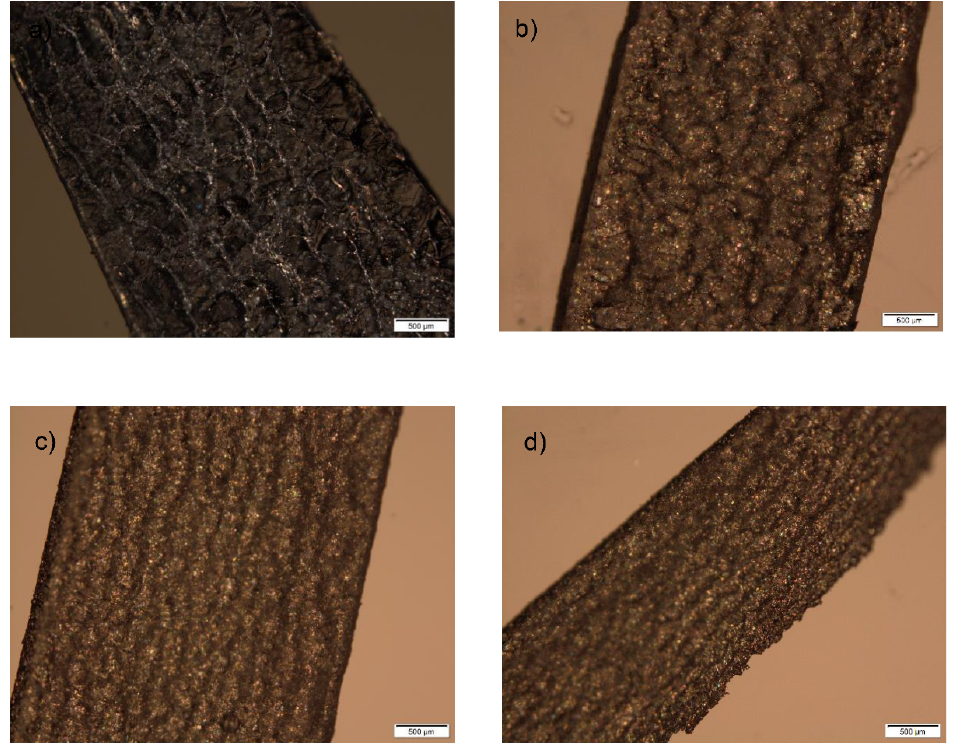
Figure 7. Cross section of tablets before dissolution testing containing: ( a ) 5%; ( b ) 10%; ( c ) 15%; ( d ) 20% of ATH.